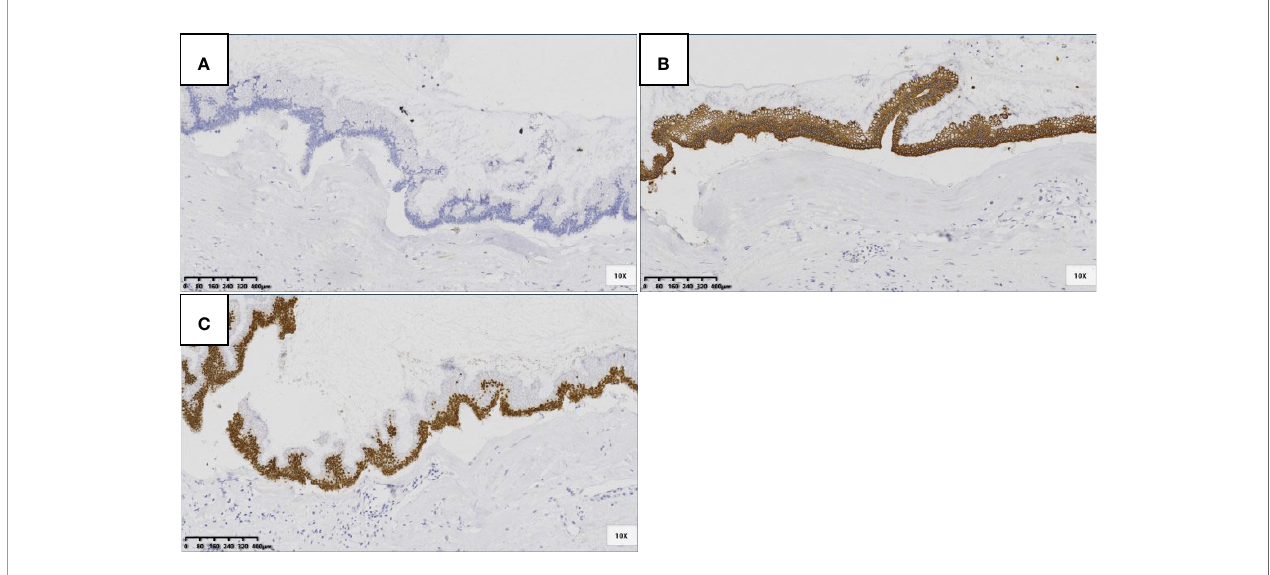
FIGURE 7 | LAMNs showed CK7 negative (A) , CK20 positive in cytoplasm (B) and CDX-2 positive in nuclear (C) (SP